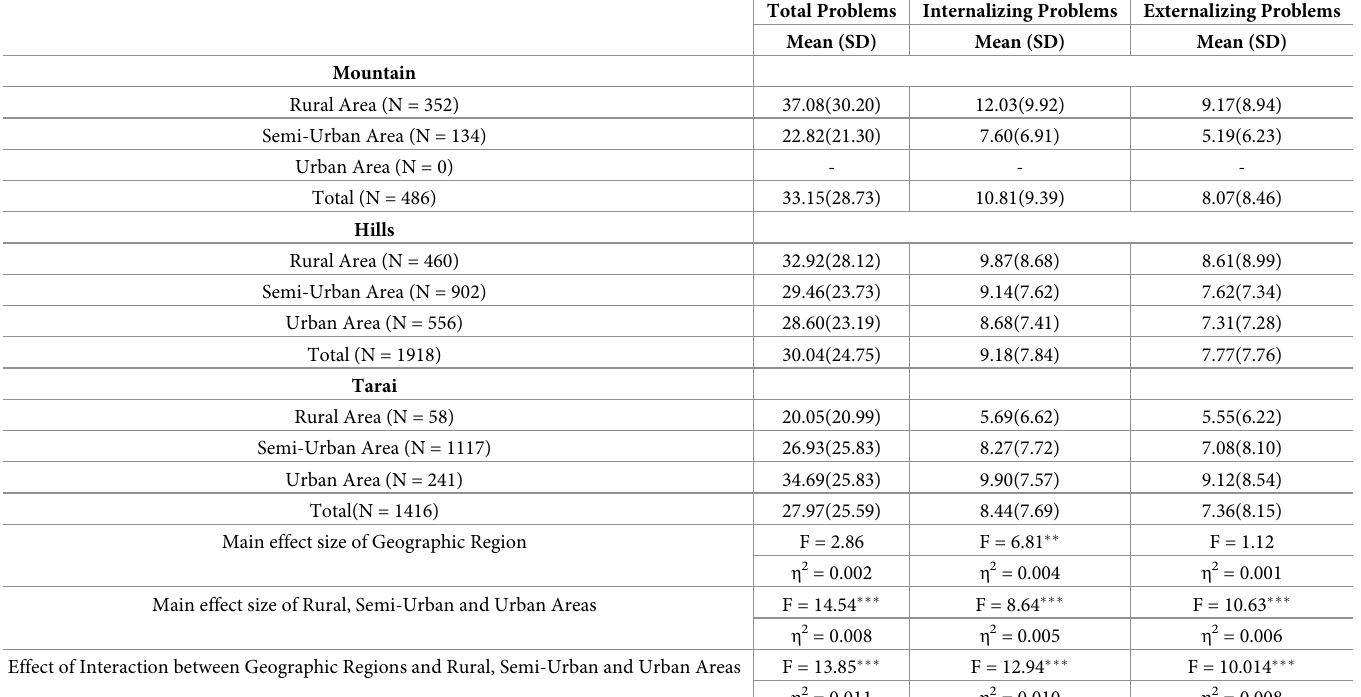
Table 6. CBCL scores by geographic regions and types of living area- Total